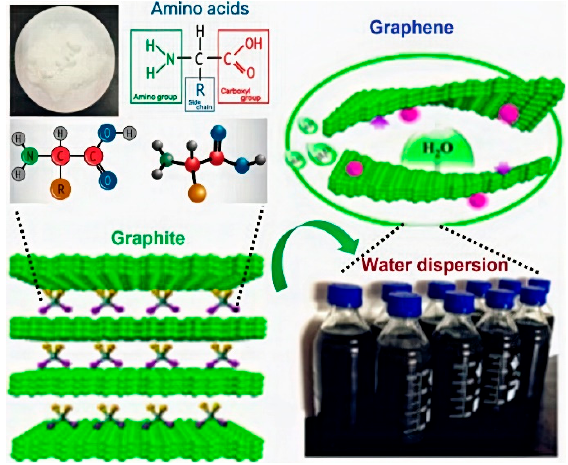
Scheme 16. The schematic presentation of amino acid assisted exfoliation of graphene. Reproduced with permission from [36], copyright 2018 American Chemical Society.